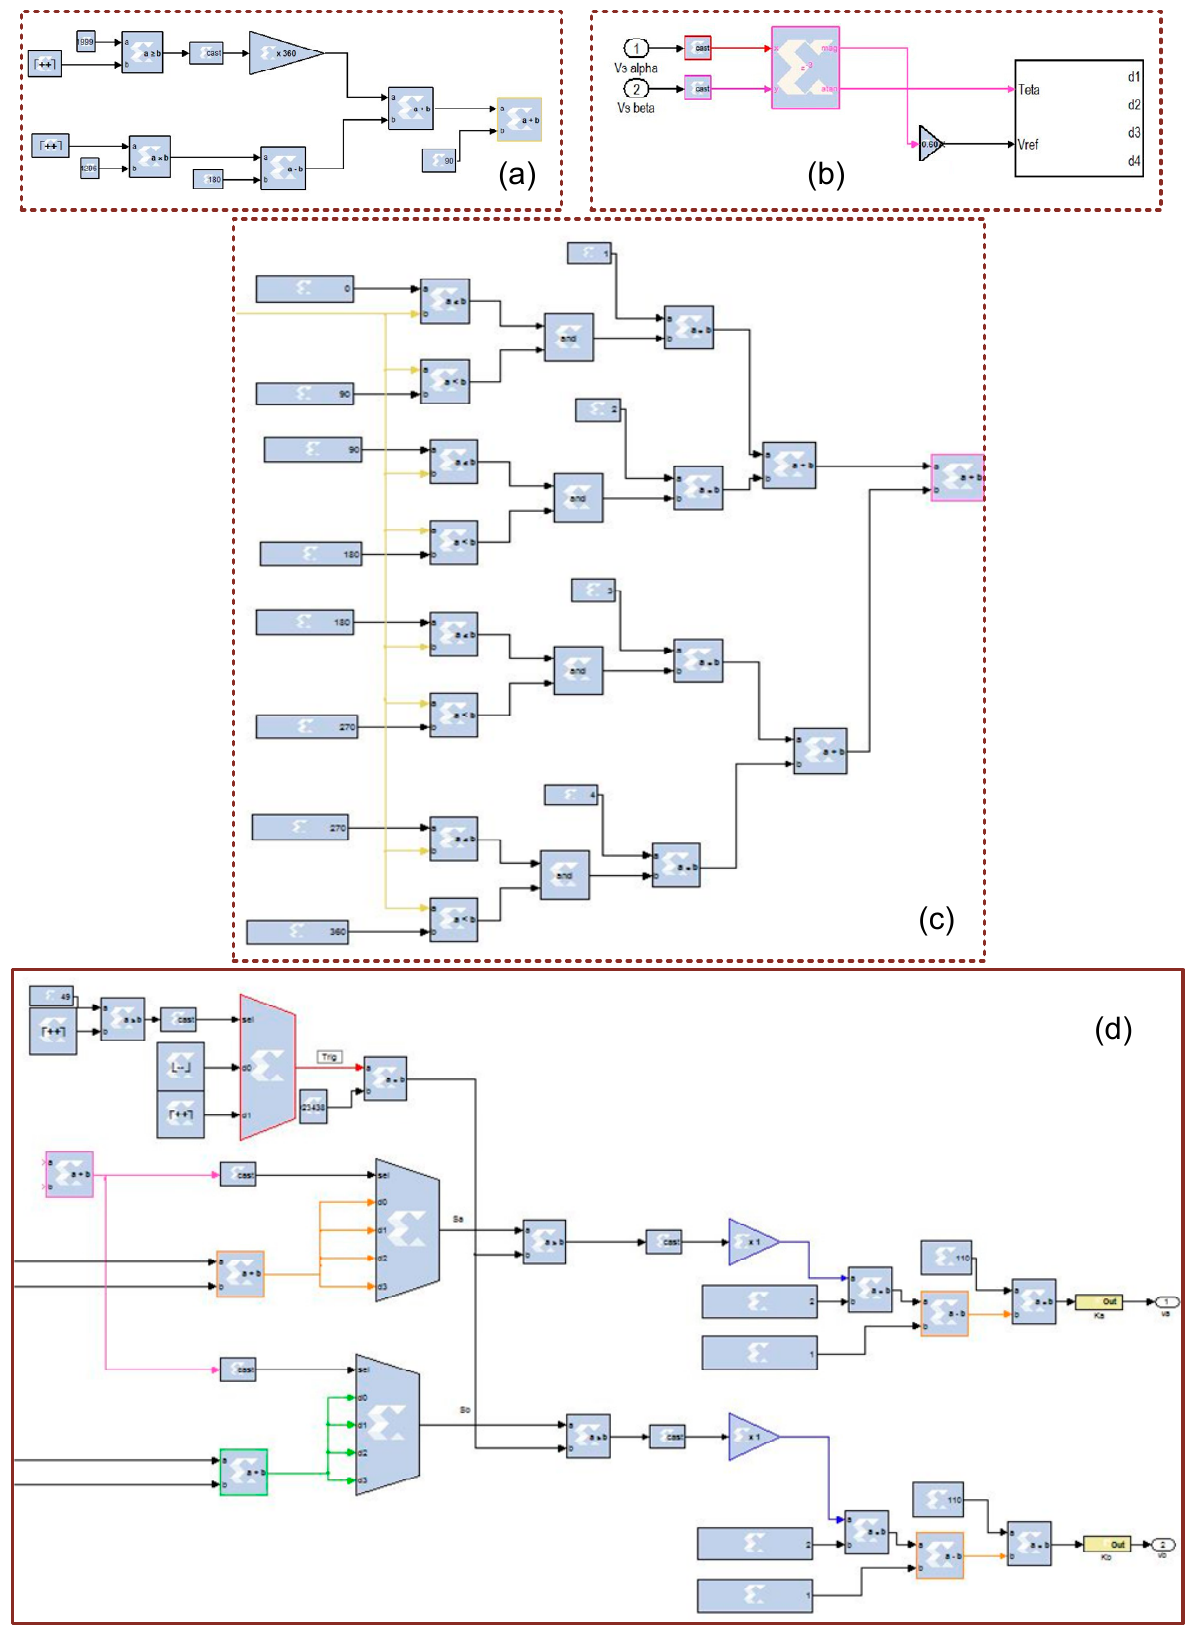
Figure 15. Advanced SVM design with XSG components: ( a ) θ s angle modeling; ( b ) duty cycles computing; ( c ) sector localization modeling and ( d ) SVM pulse generating.